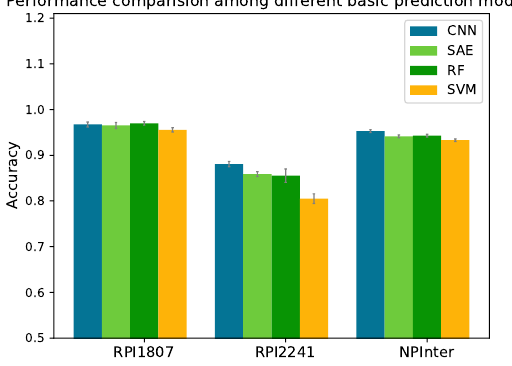
Figure 3. Performance comparison among different basic prediction models on datasets RPI1807, RPI2241 and NPInter by five-fold cross